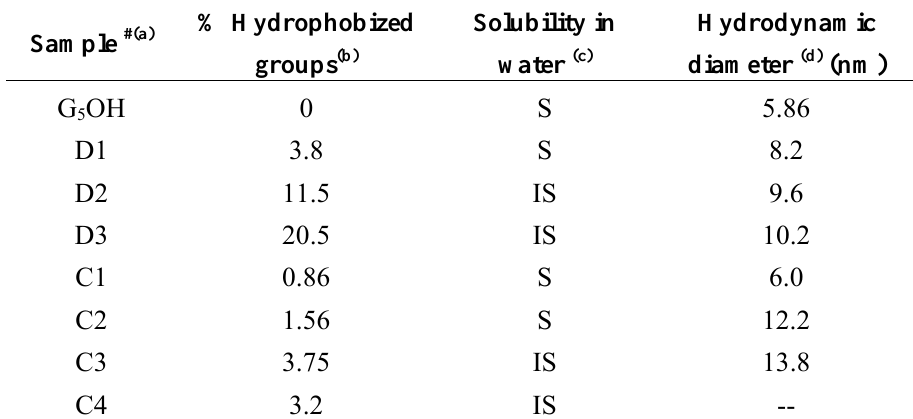
Table 1. The physicochemical properties of hydrophobically modified and unmodified